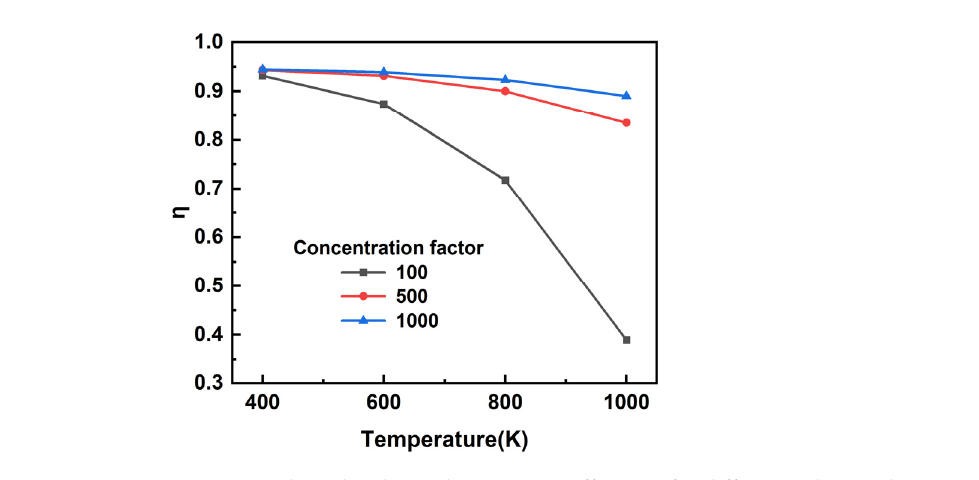
Figure 13. The Solar-thermal conversion efficiency for different solar irradiance at different temper- atures.